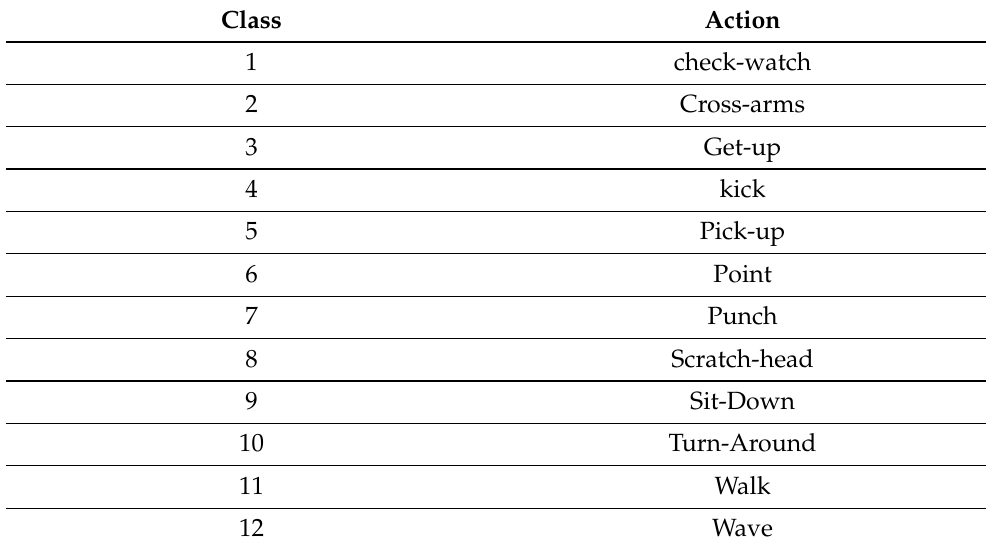
Table 3. List of actions from IXMAS Dataset.